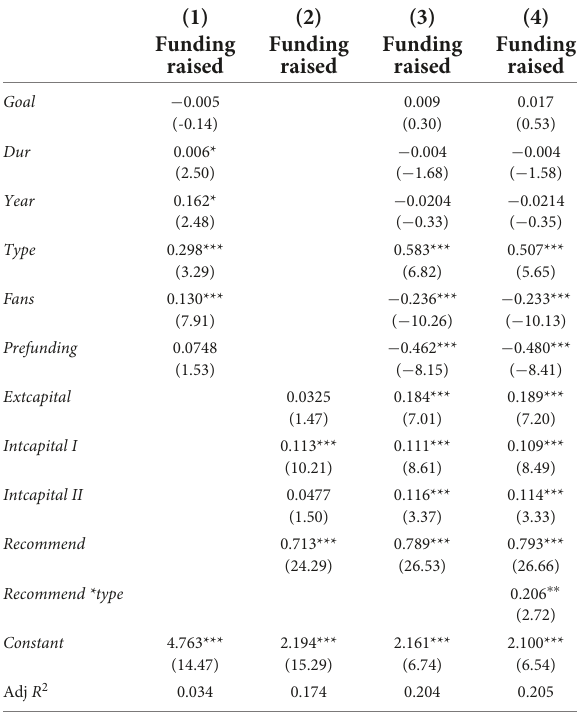
TABLE 3 Regression results.